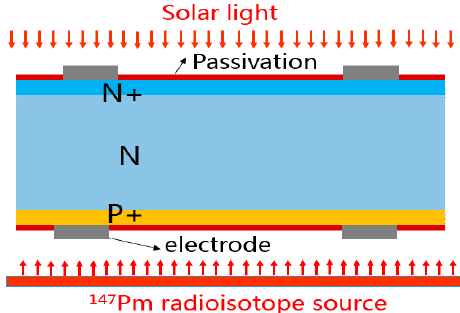
Figure 1. Schematic diagram of multi-source harvester.